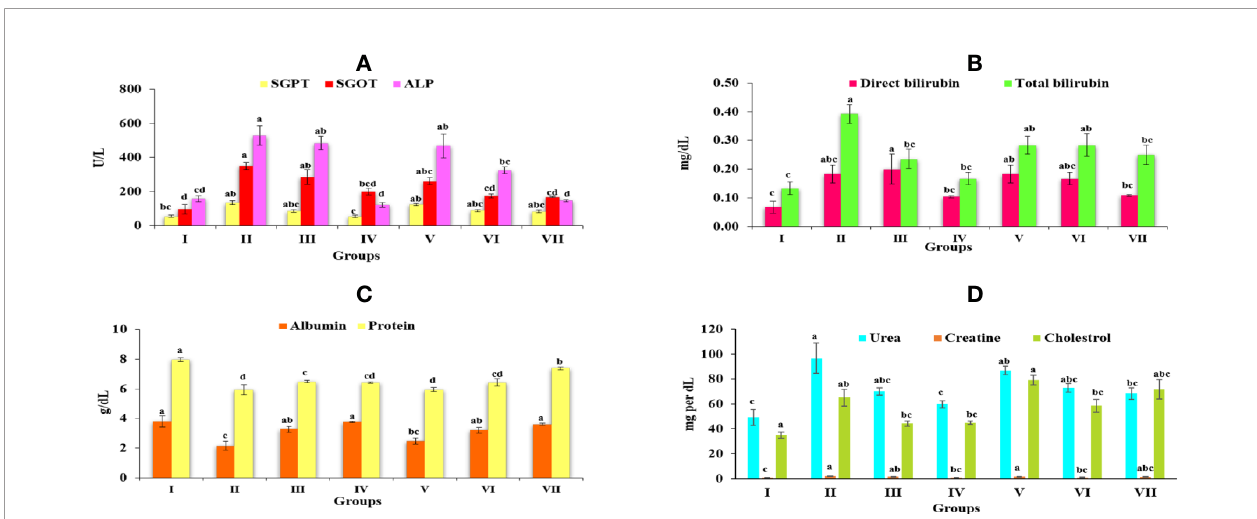
FIGURE 4 | Graph represents the effect of Obeth of O. bracteata on level of serum enzymes level in CCl 4 -treated male Wistar rats. (A) Represent the levels of SGOT, SGPT, and ALP. (B) Represent the levels of direct bilirubin and total bilirubin. (C) Represent the levels of albumin and total protein. (D) Represent the levels of urea, creatine and cholesterol. Values are expressed as Mean ± SE at level of signi fi cance p ≤ 0.05. Data labels with different letters represent signi fi cant difference among